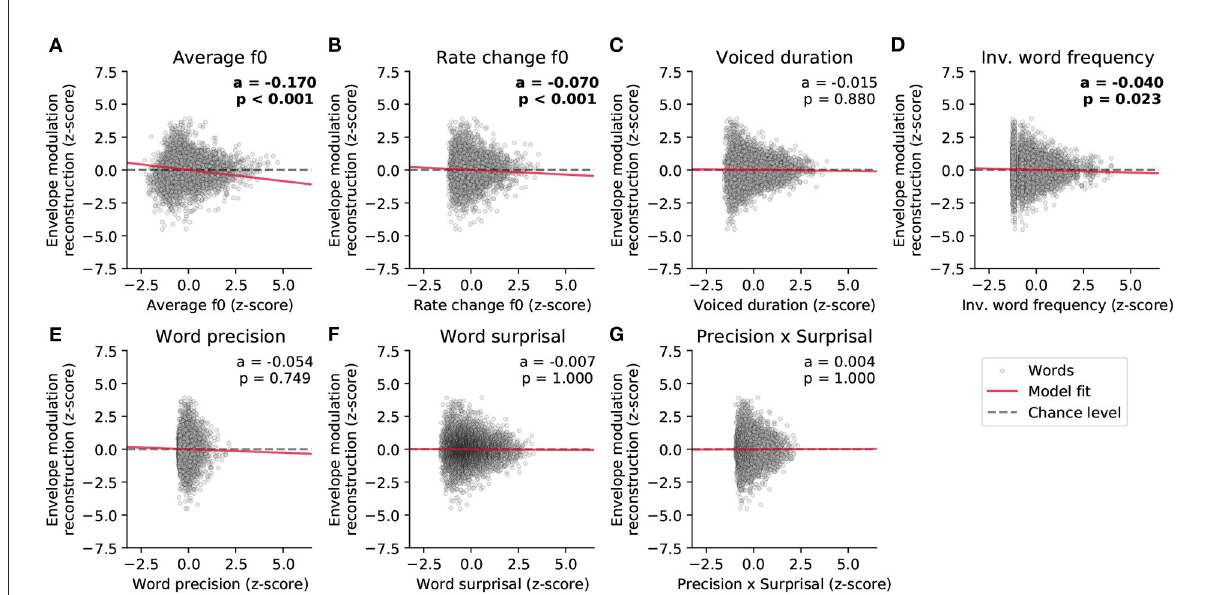
FIGURE6 Dependency of the strength of the neural response to the high-frequency envelope modulation on the different word-level features. (A–G) The world-level features and the reconstruction scores were standardized. The data points in each plot correspond to 5,732 words, and the slopes of the red lines show the coefficients of the stepwise hierarchical regression. We also detail the model coefficient (a) and the associated p -value (FDR-corrected). The gray dashed lines are horizontal and indicate no dependency.